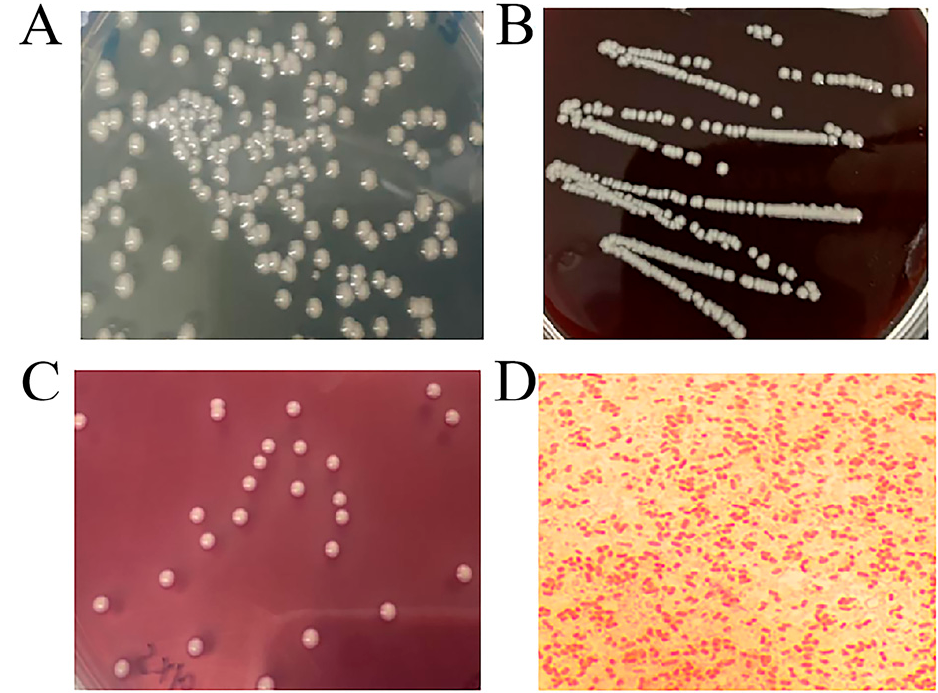
Figure 1. Culture colony morphology and Gram staining microscopic image of K. pneumoniae . ( A ) Colony morphology on TSA. ( B ) Colony morphology on blood agar. ( C ) Colony morphology on McConkey agar. ( D ) K. pneumoniae Gram staining microscopic morphology, 100 × .